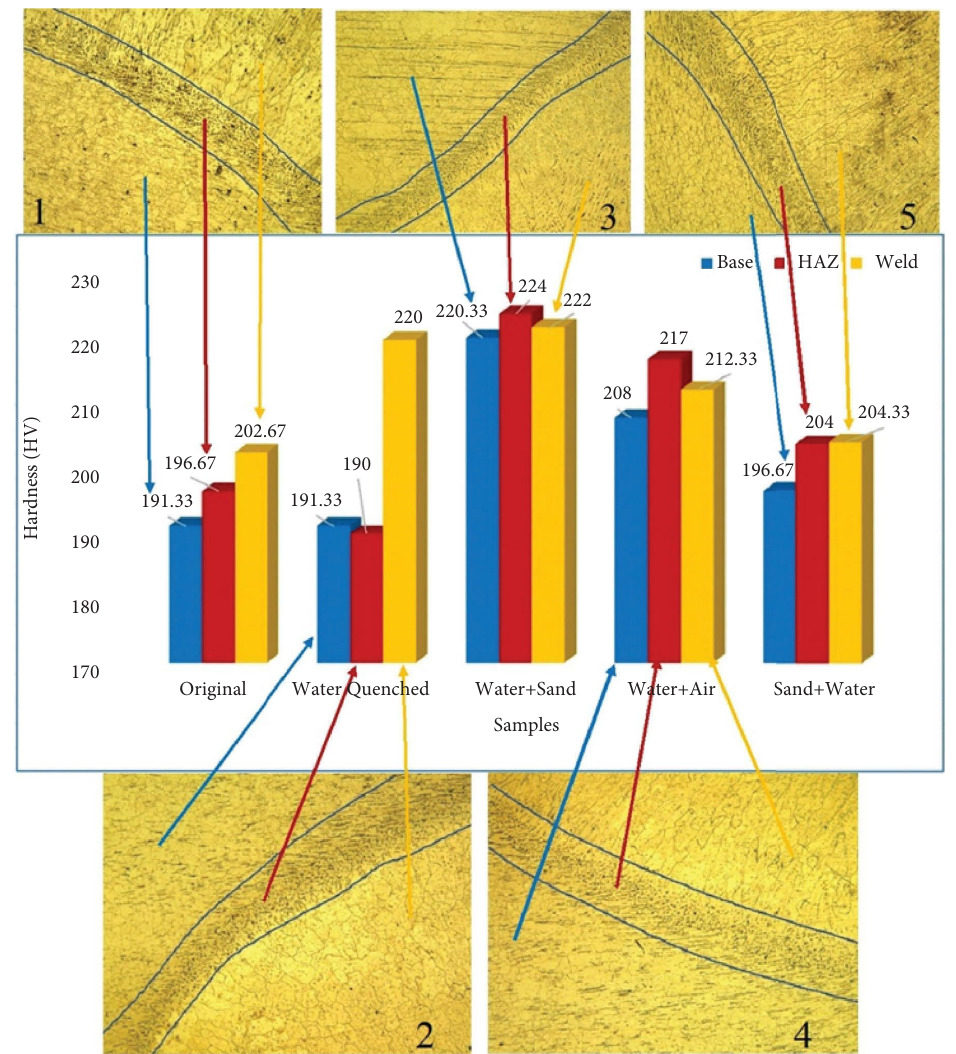
Figure 12: A comparative analysis of hardness at diferent parts of welded plates. Table 6: A comparative analysis among diferent mechanical